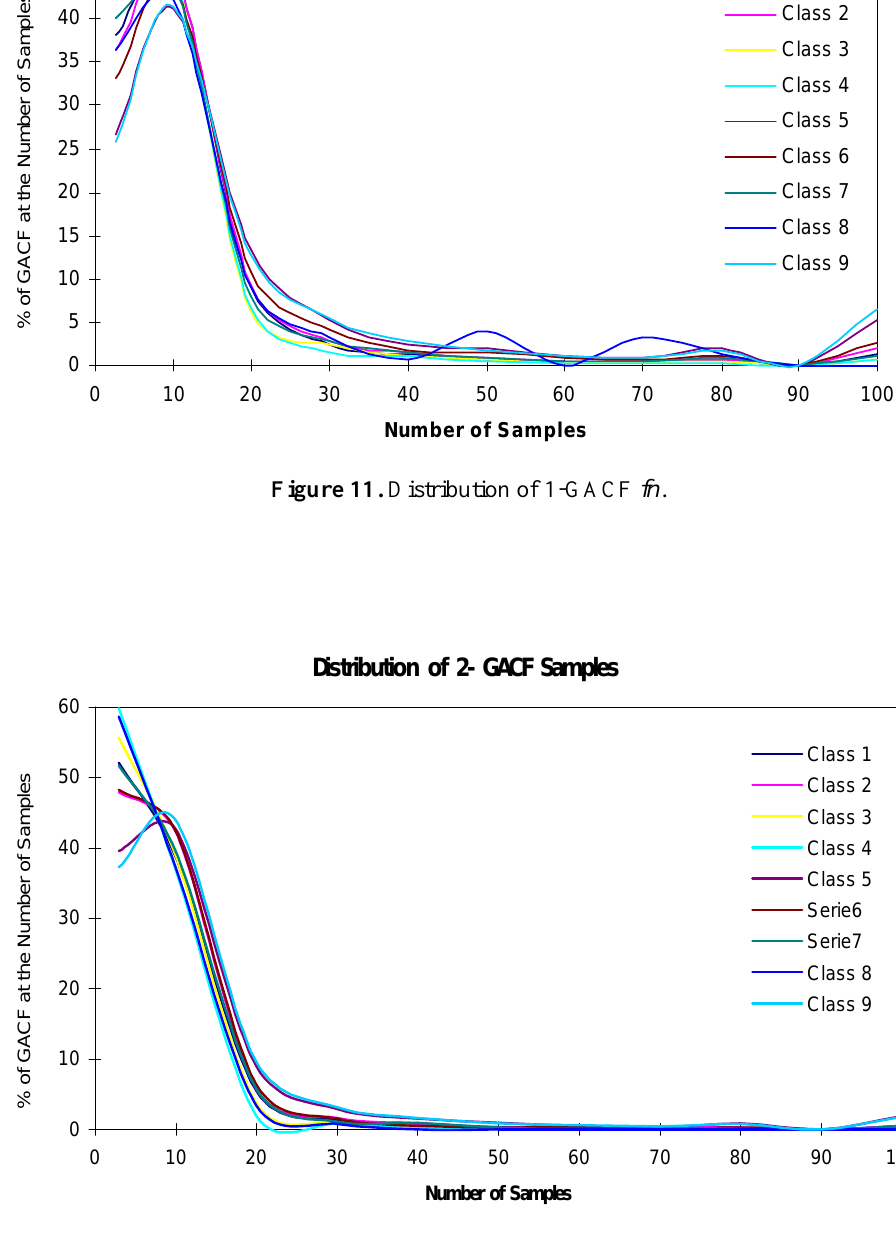
Figure 12. Distribution of 2-GACF